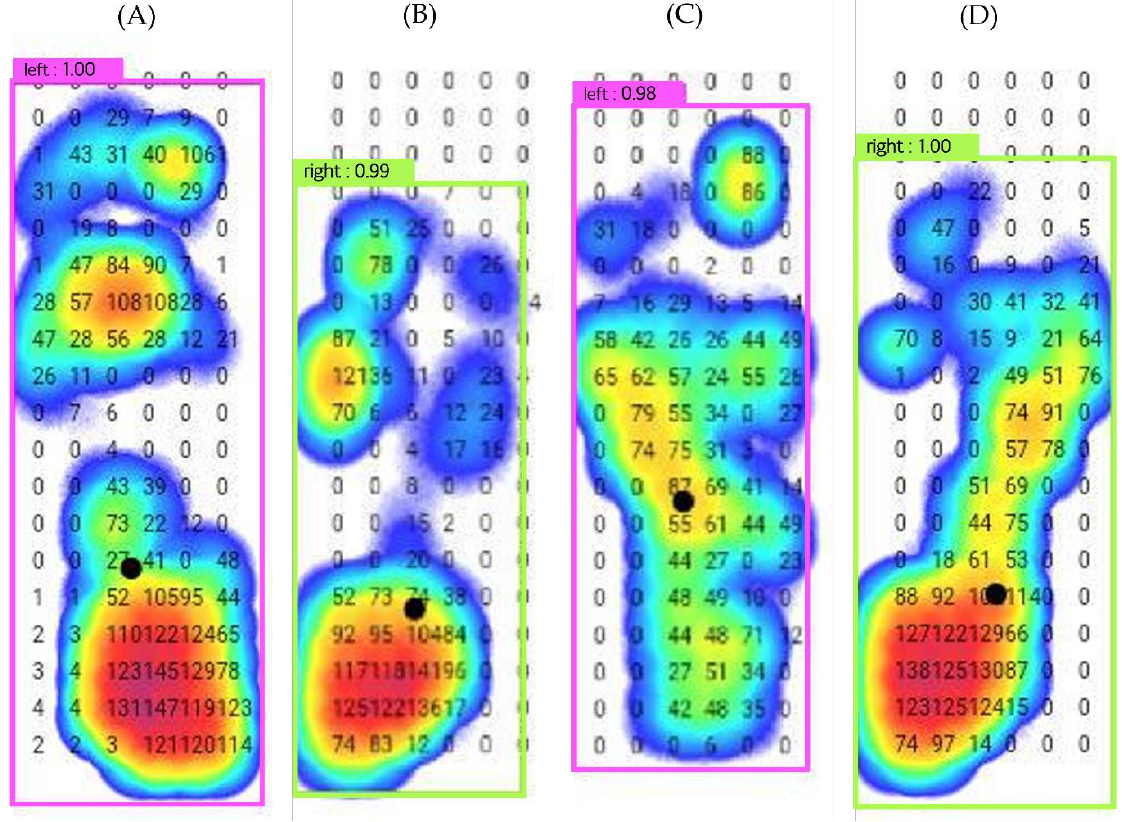
Figure 7. The prediction sample of detection in YOLOv4: ( A ) the defective plantar pressure images on the midfoot. ( B ) The complex plantar pressure on the forefoot and midfoot. ( C ) The complex plantar pressure with less pressure at full foot. ( D ) The plantar pressure image on the forefoot with abnormal foot progression angle.